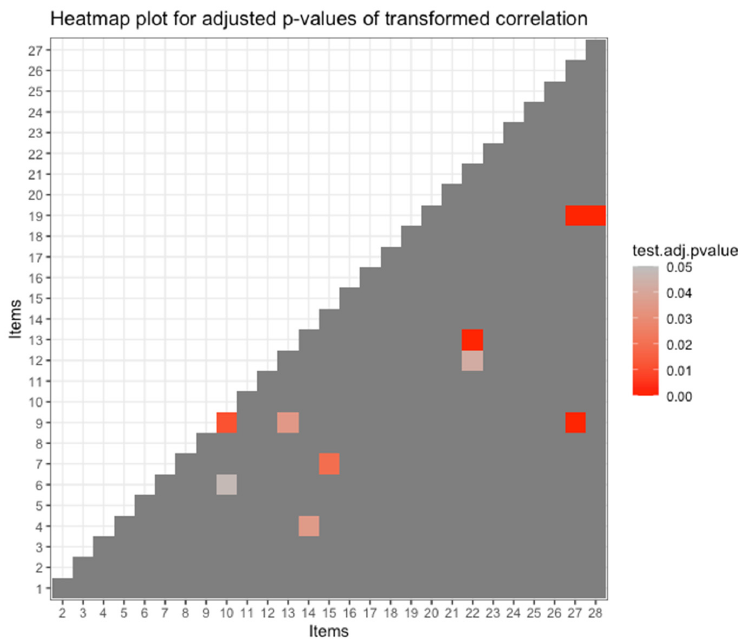
Figure 4. Heatmap plot for adjusted p -values for transformed correlation.